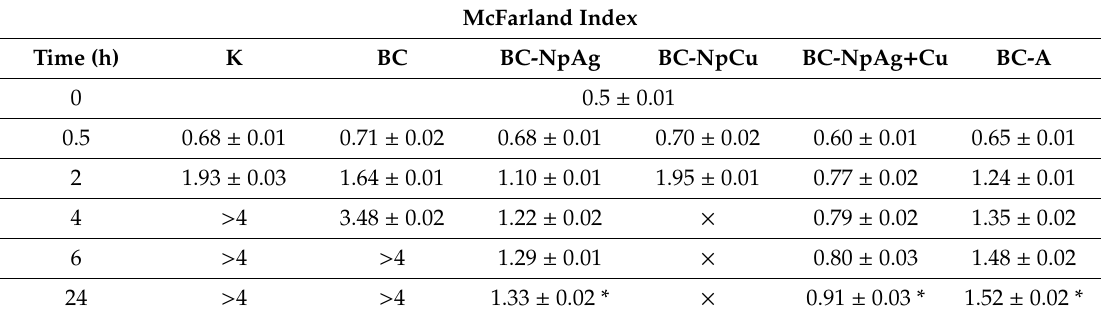
Table 2. McFarland standard values specifying the number of Staphylococcus aureus bacteria during incubation with tested specimens: Modified bone cements—1.5% w/w of modifiers additive (n = 3; mean ± SD; * significantly different from control— p < 0.05).